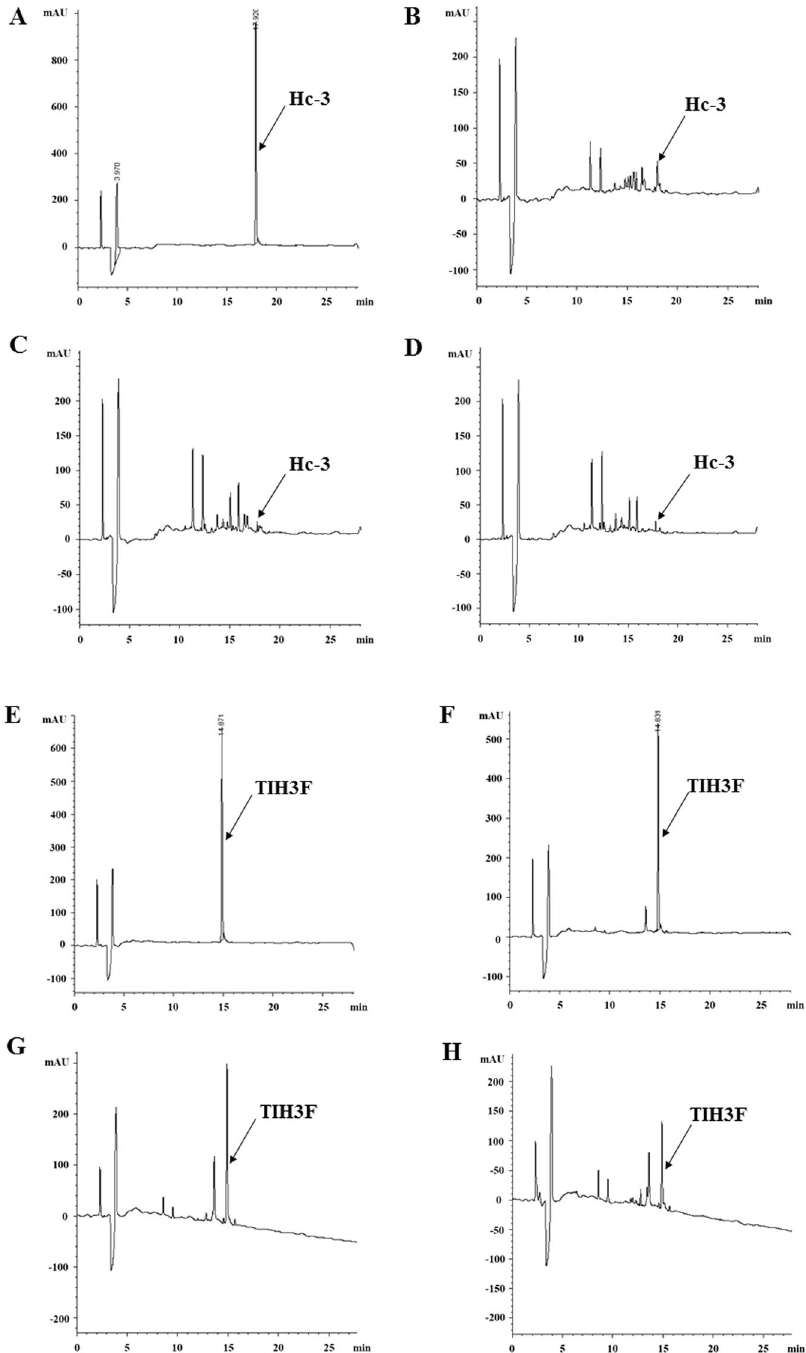
Figure 4. Analytical reversed-phase HPLC traces of Hc-3 and TIH3F after treatment with trypsin for different times. ( A ) LC analysis of pure Hc-3. LC analysis of Hc-3 after incubation with trypsin at 37 °C for ( B ) 6 h ( C ) 12 h and ( D ) 24 h. ( E) LC analysis of pure TIH3F. LC analysis of TIH3F after incubation with trypsin at 37 °C for ( F ) 6 h ( G) 12 h and ( H ) 24